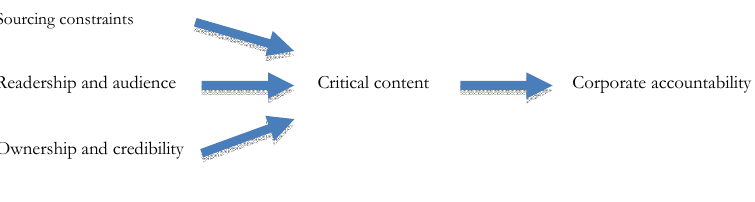
Figure 1: Model of theoretical relationship between news coverage